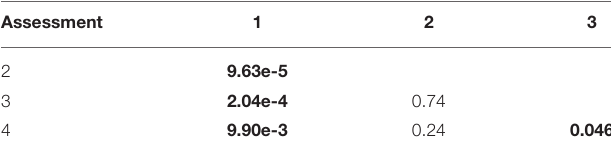
Bolded values indicate a significant difference (p < 0.05).